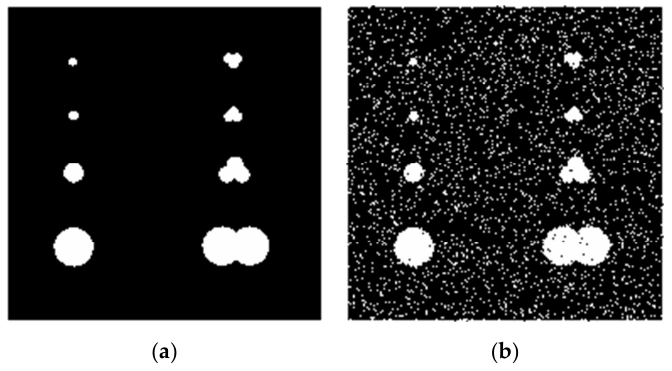
Figure 7. Ultrasonic testing simulation images. ( a ) original image; ( b ) noised image. Table 2. Result of the combination of different structure element ( SE ) and different operations. Line SE Triangular SE Circular SE